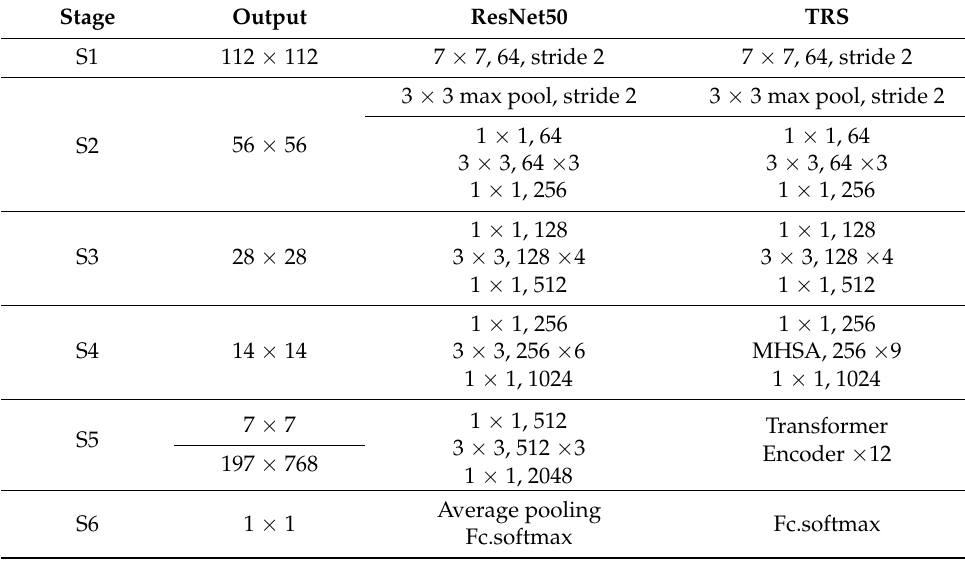
Figure 1. Overall architecture of the Remote Sensing Transformer. The scene we choose as an example is the airplane. Table 1. The details of the TRS model.